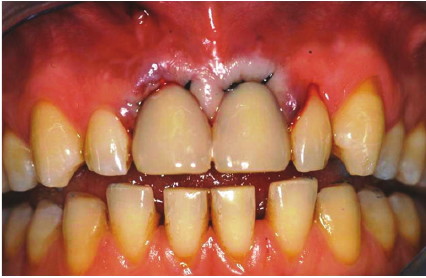
Figure 3: Temporary adhesive system attached to the adjacent